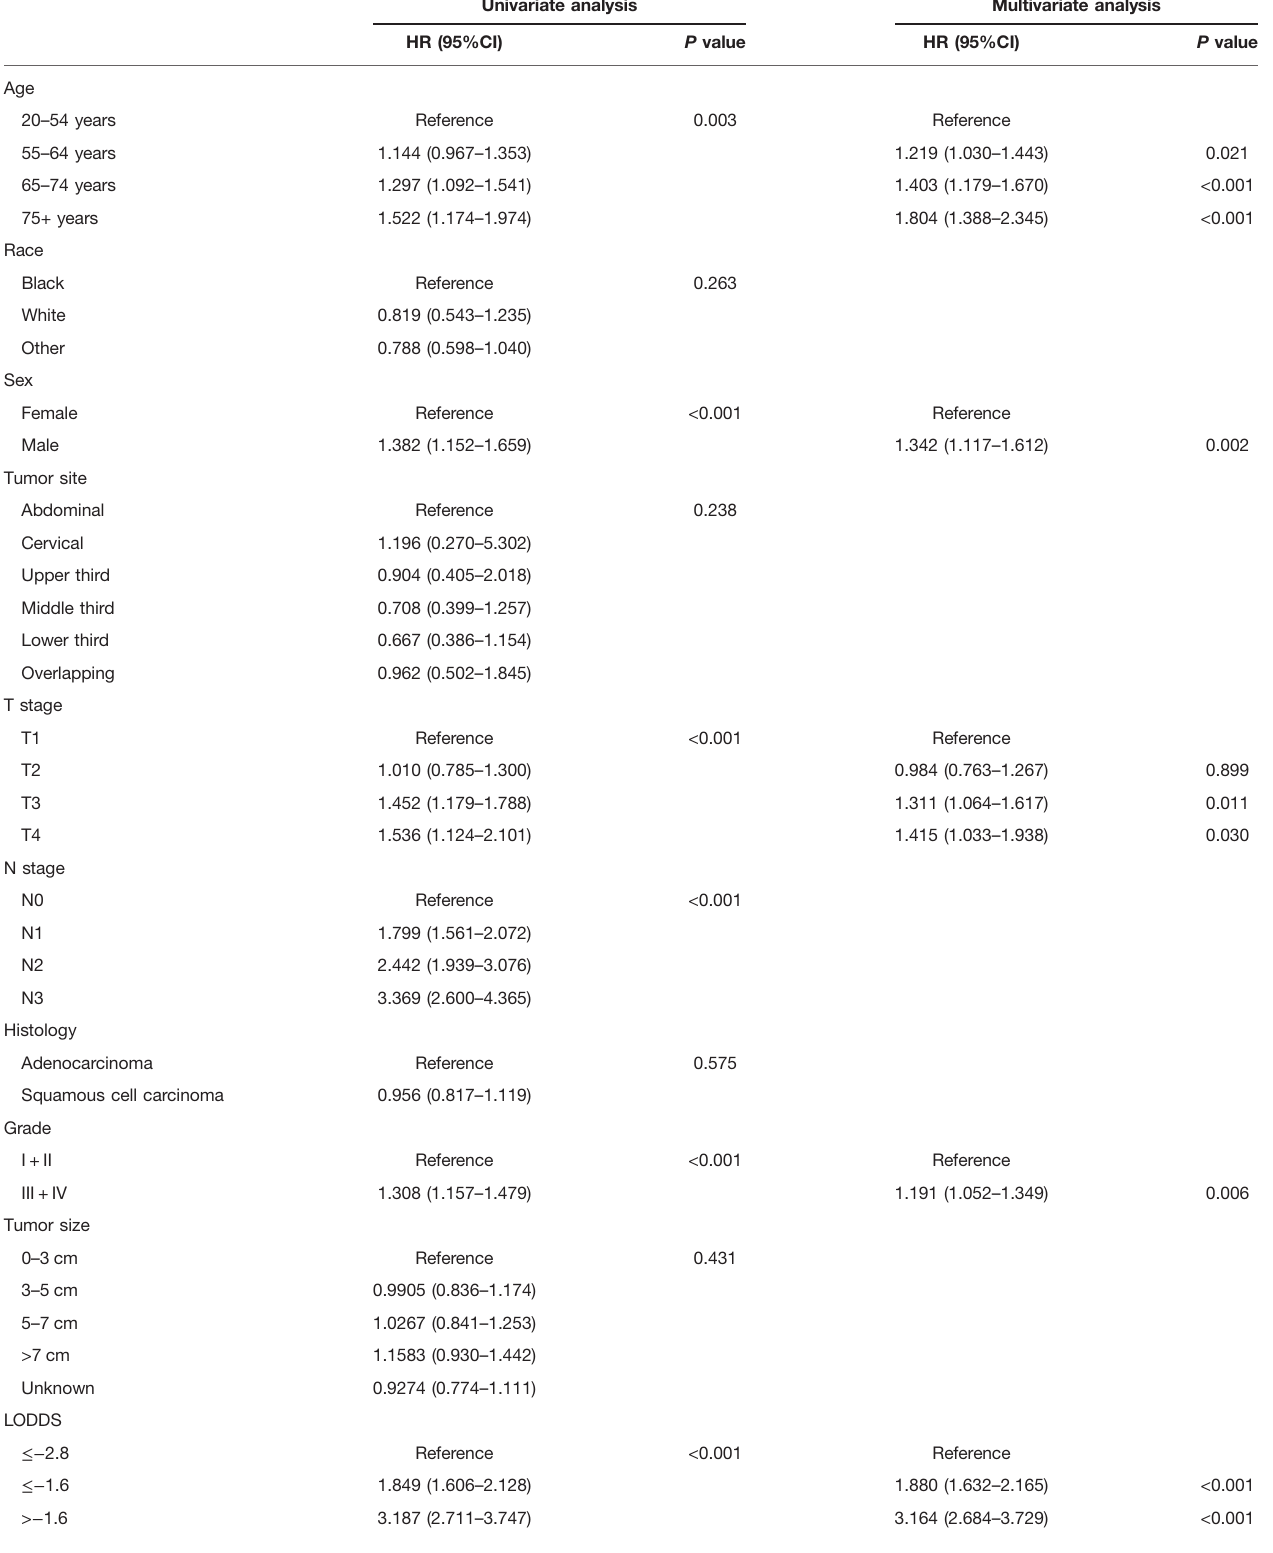
TABLE 3 | Univariate and multivariate Cox regression analysis of each factor ’ s ability for predicting OS in the training